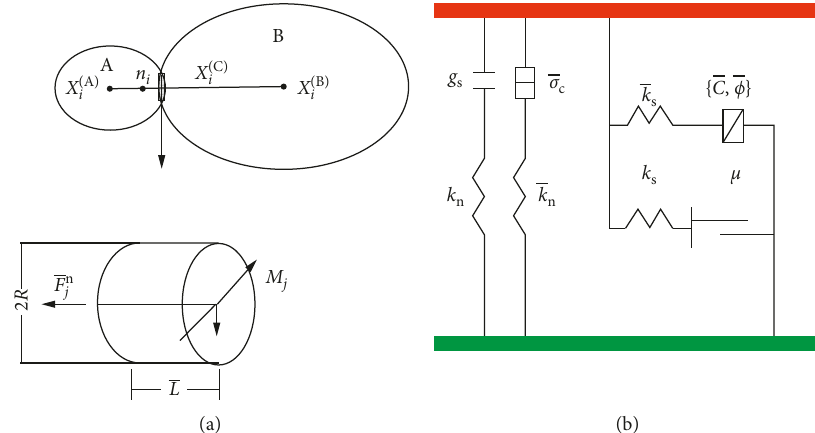
Figure 1: Linear parallel bond model. (a) Mechanical relationship between particles. (b) Mechanical relationship of linear parallel bond model.